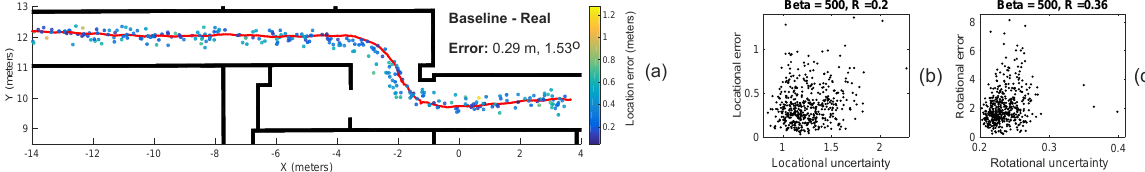
Figure 7. Baseline performence of a network fine-tuned and validated using real images with β = 500 . (a) The distribution of the estimated camera poses. The red line shows the ground truth trajectory estimated using SfM approaches. The colours represent the magnitude of the errors corresponding to each point. The locational and rotational errors are in meters and degrees respectively. (b)